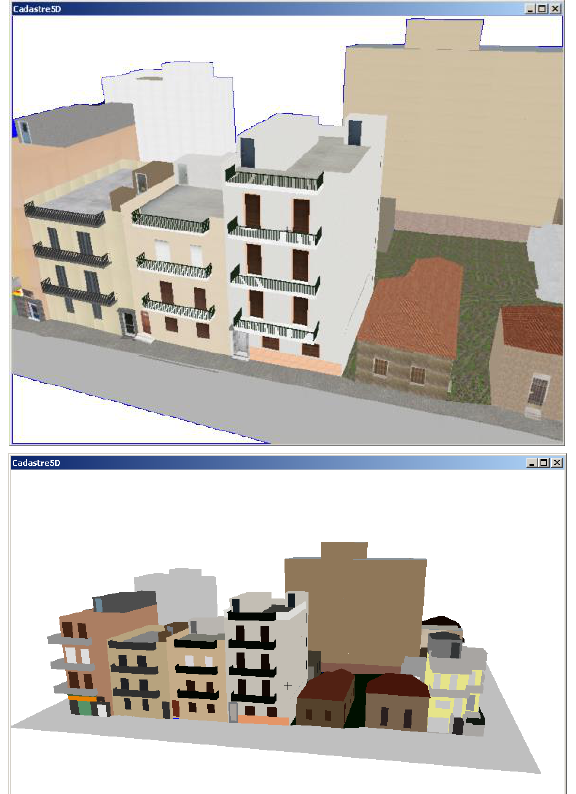
Figure 14. 3D view of the building models of 2010 at LoD3 (top) and LoD2